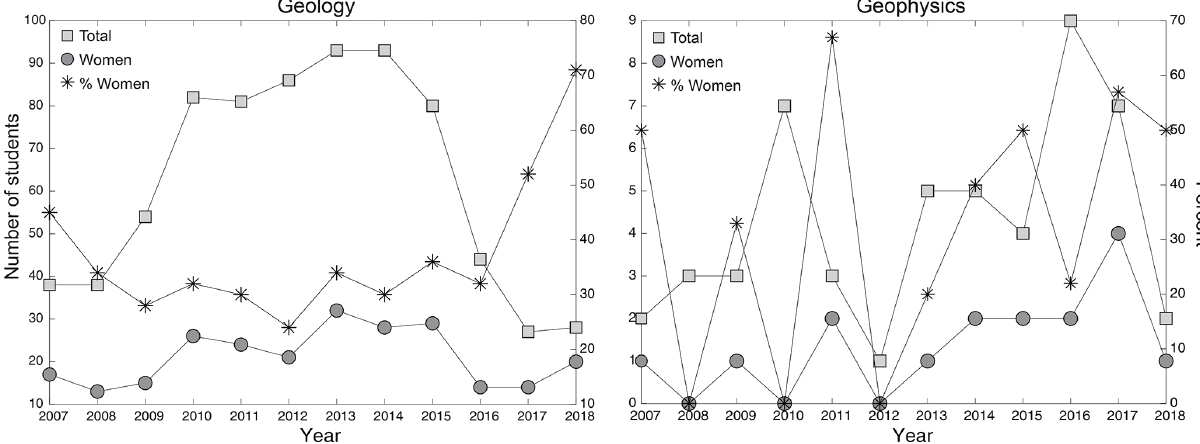
Figure 2. Number of students enrolled in geology and geophysics majors during the period 2007–2018.